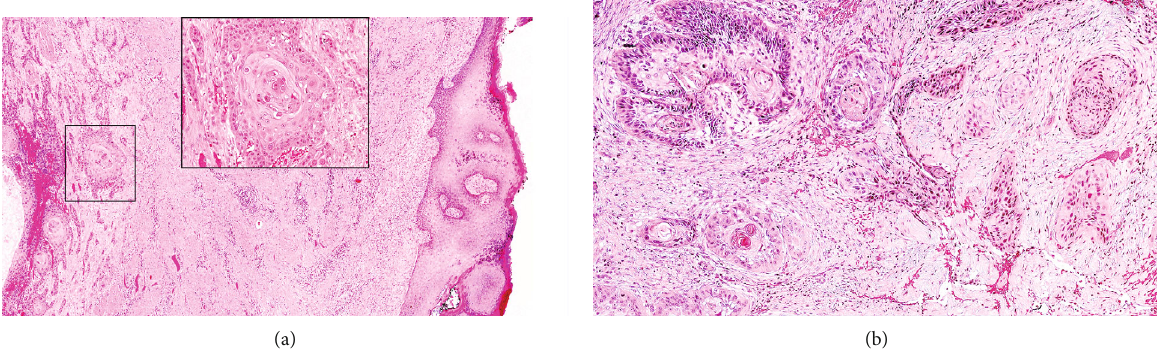
Figure 3: Representative sections of the surgical specimen of case 2 (hematoxylin and eosin staining): surgical resection specimen of the buccal patch (a; original magni fi cation × 50); keratinized epithelium on the right side of the image on the left side lies the in fi ltrating carcinoma (inset: detail at higher magni fi cation of squamous nature consisting in keratin pearl). Aggregates and nests of intensely eosinophilic neoplastic cells with densely, hyperchromatic nuclei and keratinizing features are widely identi fi ed all over the specimen, con fi rming the carcinoma ’ s squamous nature (b; original magni fi cation ×